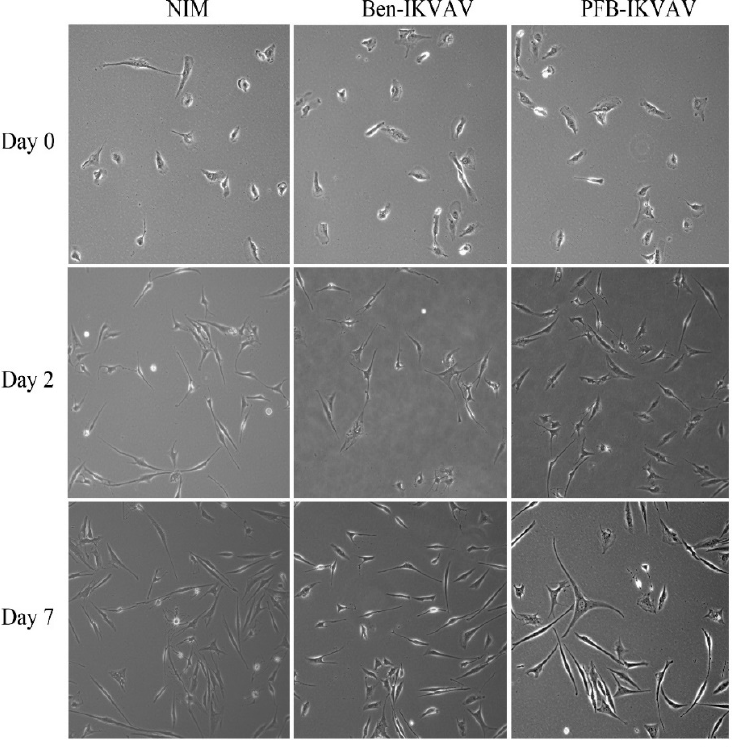
Figure 7. The optical microscope images of cell morphology of hMSCs cultured with NIM (control, left), NIM in the presence of Ben-IKVAV (middle) , and NIM in the presence of PFB-IKVAV (right) for 2 days and 7 days. (Scale bar: 50 μ m).